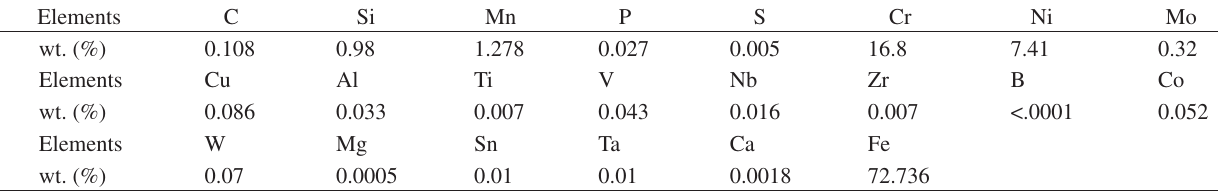
Figure 1. Test specimen geometry. Table 1. Nominal chemical composition (in wt. (%)) of the used austenitic steel. Elements